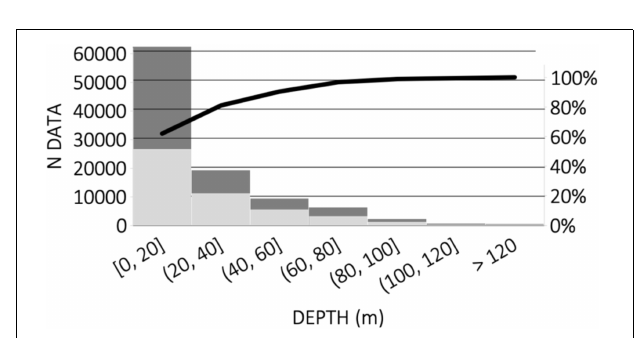
FIGURE 3 | Vertical distribution of data collected by all sea turtles between January 2019 and April 2020. Number of observations (NDATA) between 0 and 120 m in 20 m increments at all times (dark gray) and at night (18–5, Reunion Island Local Standard Time) only (light gray). The black line indicates the cumulative percentage of collected